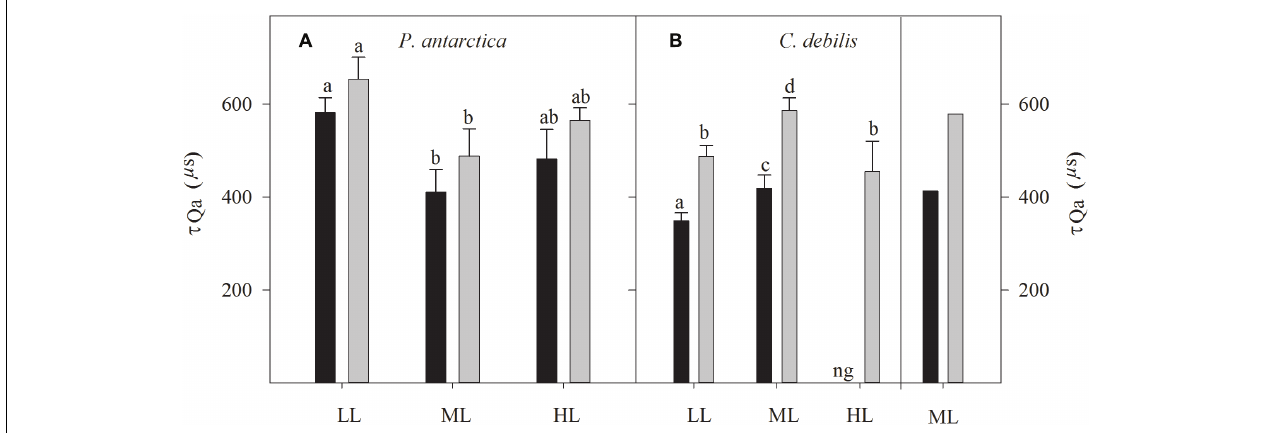
) are shown for P. antarctica (A) and C. debilis (B) acclimated to control (black FIGURE 4 | Measured re-oxidation times of the primary electron acceptor Q a ( τ Q a bars) or Fe-enriched (grey bars) conditions combined with low (LL), medium (ML) or high light (HL). C. debilis did not grow in control HL treatments as indicated by ng. Values represent the means ± SD ( n = 3). Different letters indicate significant differences between treatments ( p < 0.05). On the right side of panel B calculated τ Q of the ML accclimated C. debilis cells grown under Fe-enriched (gray bars) or control (black bars) conditions are presented. Calculations were done using the a adapted model by Kroon and Thoms (2006). The values of τ Q were calculated from the inverse of the decay constant for the Q A -Q B complex based on the adapted a model of Kroon and Thoms (2006), which is illustrated in Supplementary Figure S1 .